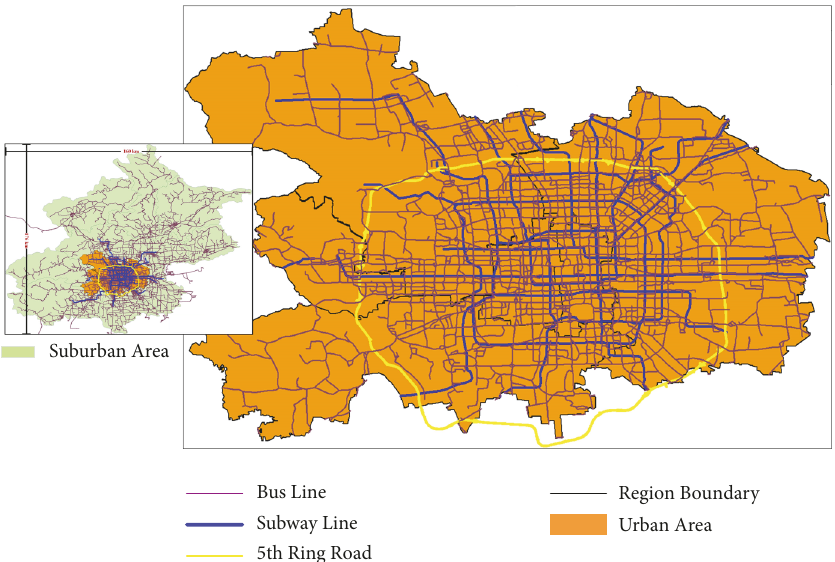
Figure 1: Administrative map of Beijing with the bus transit and subway